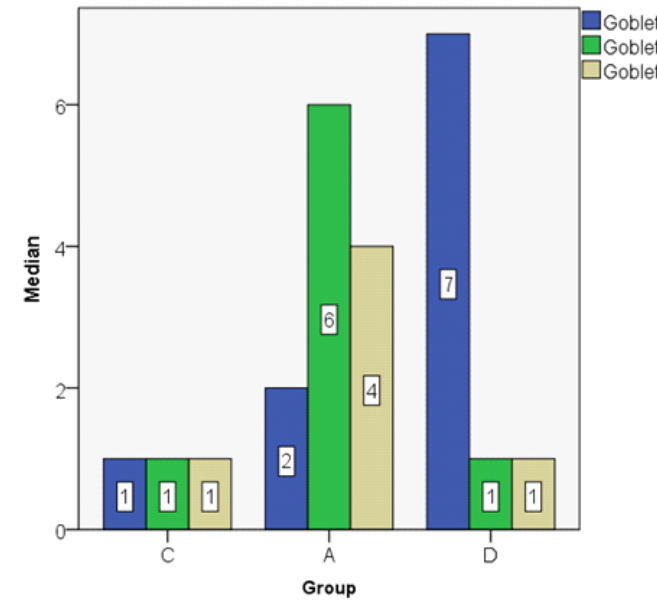
Figure 15. Goblet cell count (median).